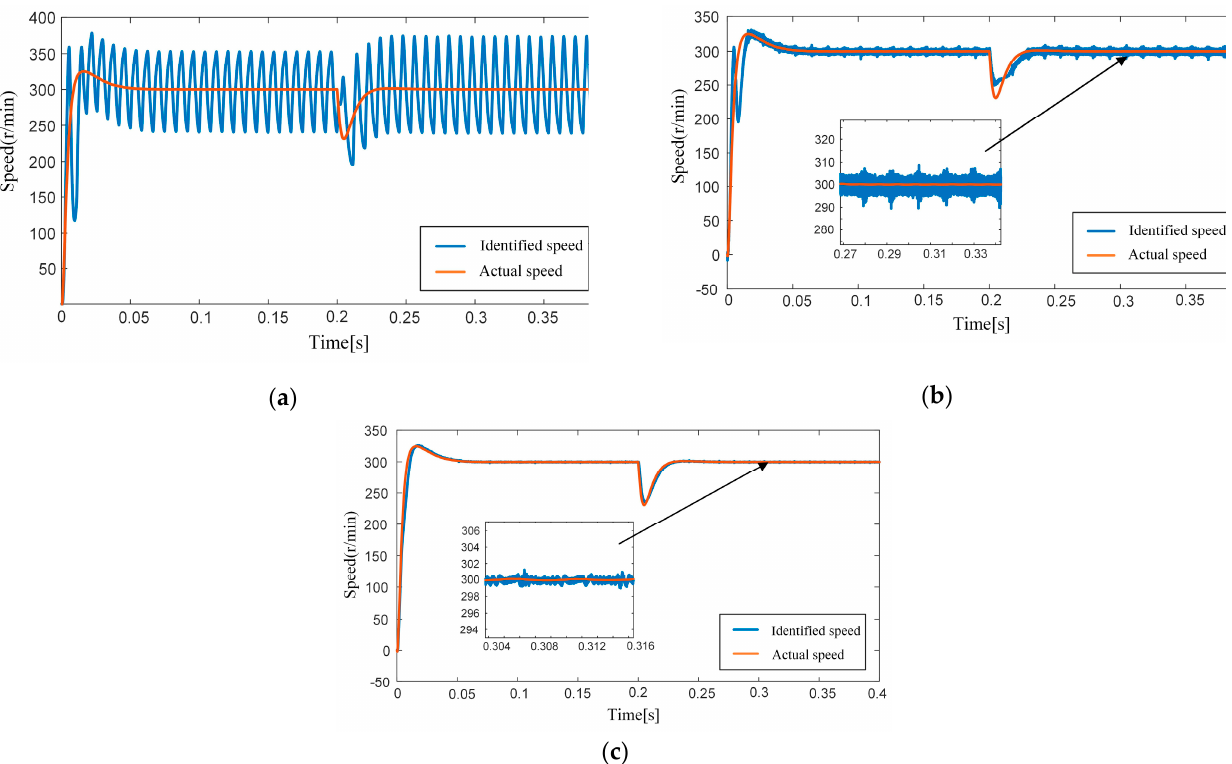
Figure 10. Speed estimation waveform: ( a ) The traditional sliding mode; ( b ) the traditional sliding mode + dead zone compensation; ( c ) adaptive sliding mode observer + dead zone compensation.